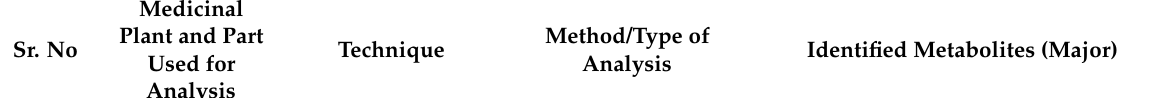
Table 1. Quality and quantitative metabolomic analysis of medicinal plants using the modern analytical